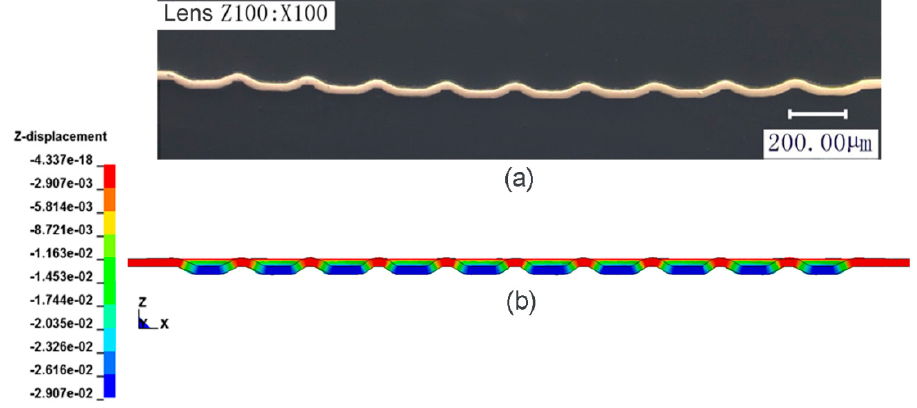
Figure 17. The cross-section images of the whole ten array channels: ( a ) experimental result and ( b ) simulation result.